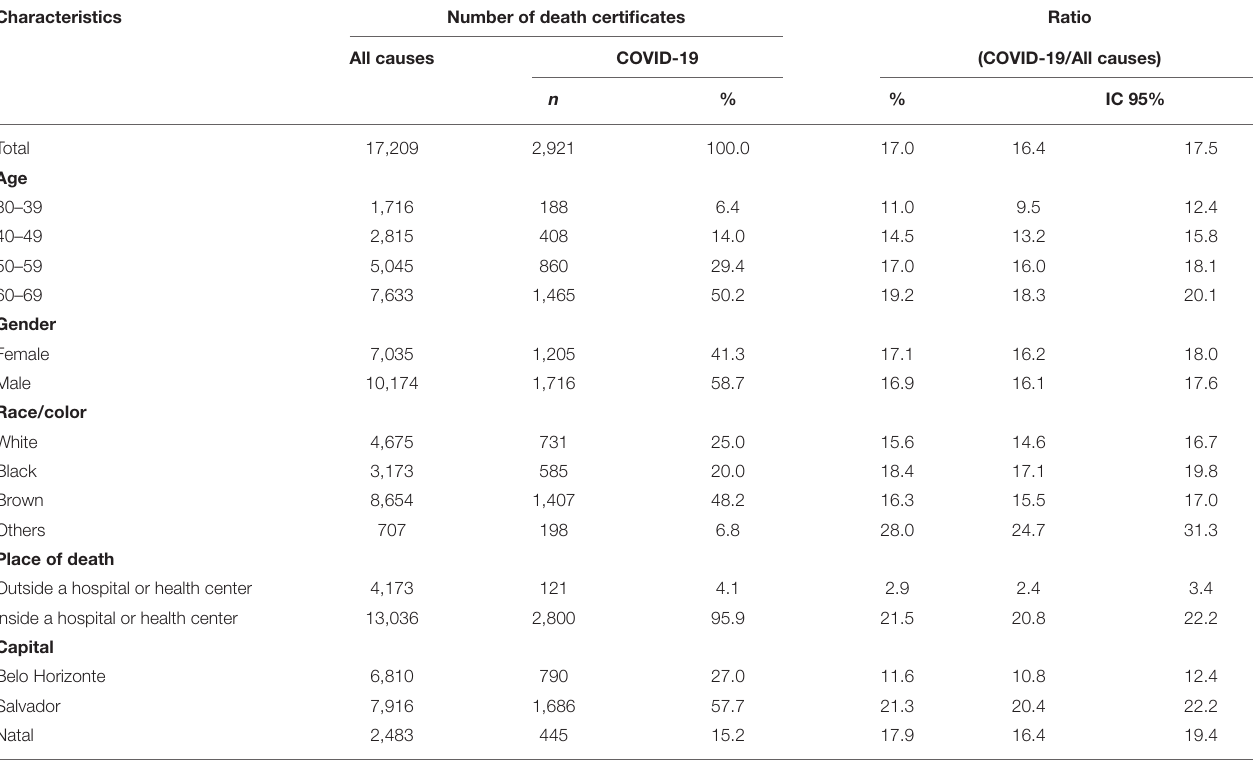
TABLE 1 | Number of death certificates due to COVID-19 and all causes of death according to characteristics of the deceased and local of death, at ages 30–69 years, in three Brazilian capitals, 2020.